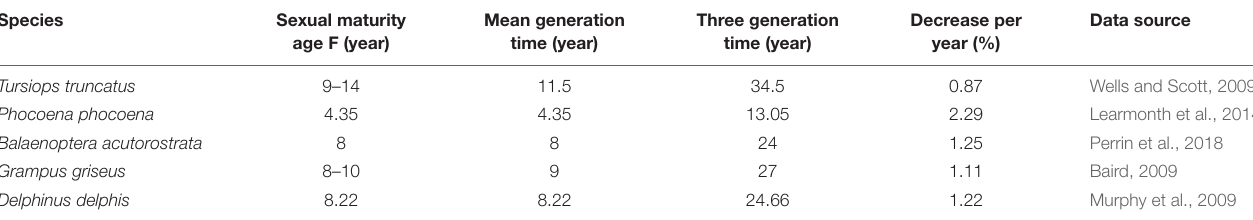
TABLE 1 | Generation time and decrease per year that should be detected for the main coastal cetacean species present in Scotland, calculated based on a 30% decrease over three